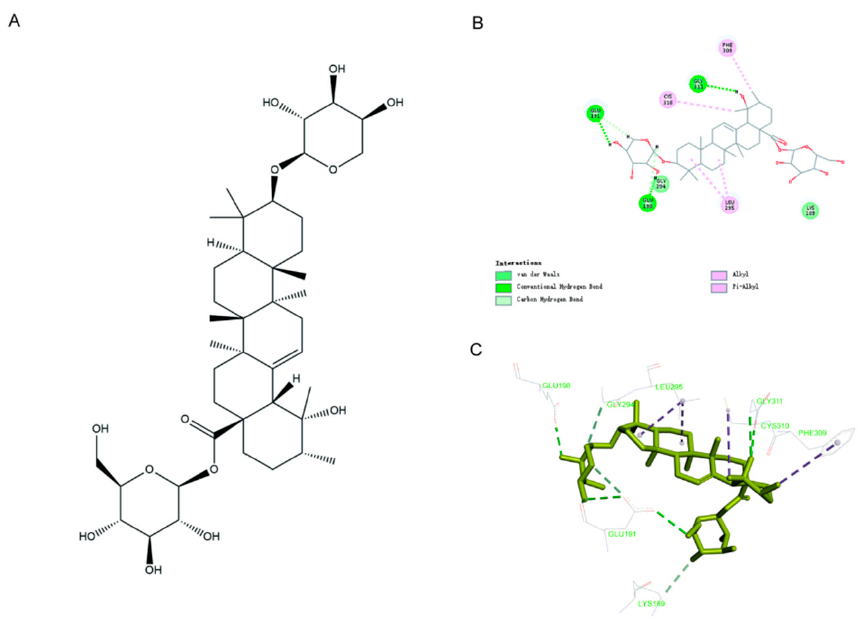
Figure 5. Molecular docking results for Ziyu I docking with Akt1. ( A ) Molecular structure of Ziyu I ( B ). A planar view of the docking results of Ziyu I and Akt1. The dashed line represents the existing interaction force between the ligand and receptor. ( C ). Three-dimensional diagram of the docking results of Ziyu I and Akt1. Yellow represents the Ziyu I, and green marks the amino acid residues. The dotted line represents the existing interaction force between the ligand and the receptor.